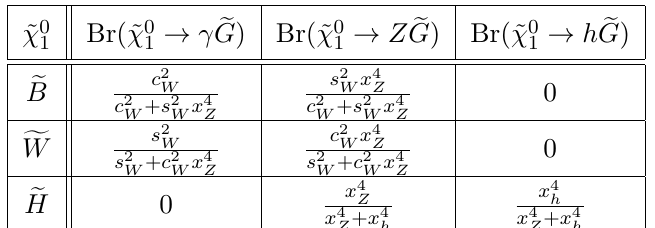
Table 4 . Branching ratios for the pure neutralino states at the large tan β regime. x I ≡ (1 − ) with I = Z, h are used. In the heavy ˜ χ 0 m 2 /m 2 I ˜ χ 0 1 Br( f W → Z e G ) = c 2 ’ 0 . 77 and Br( e H → Z e G ) ∼ Br( e H → h e G ) ∼ 0 . 5 W